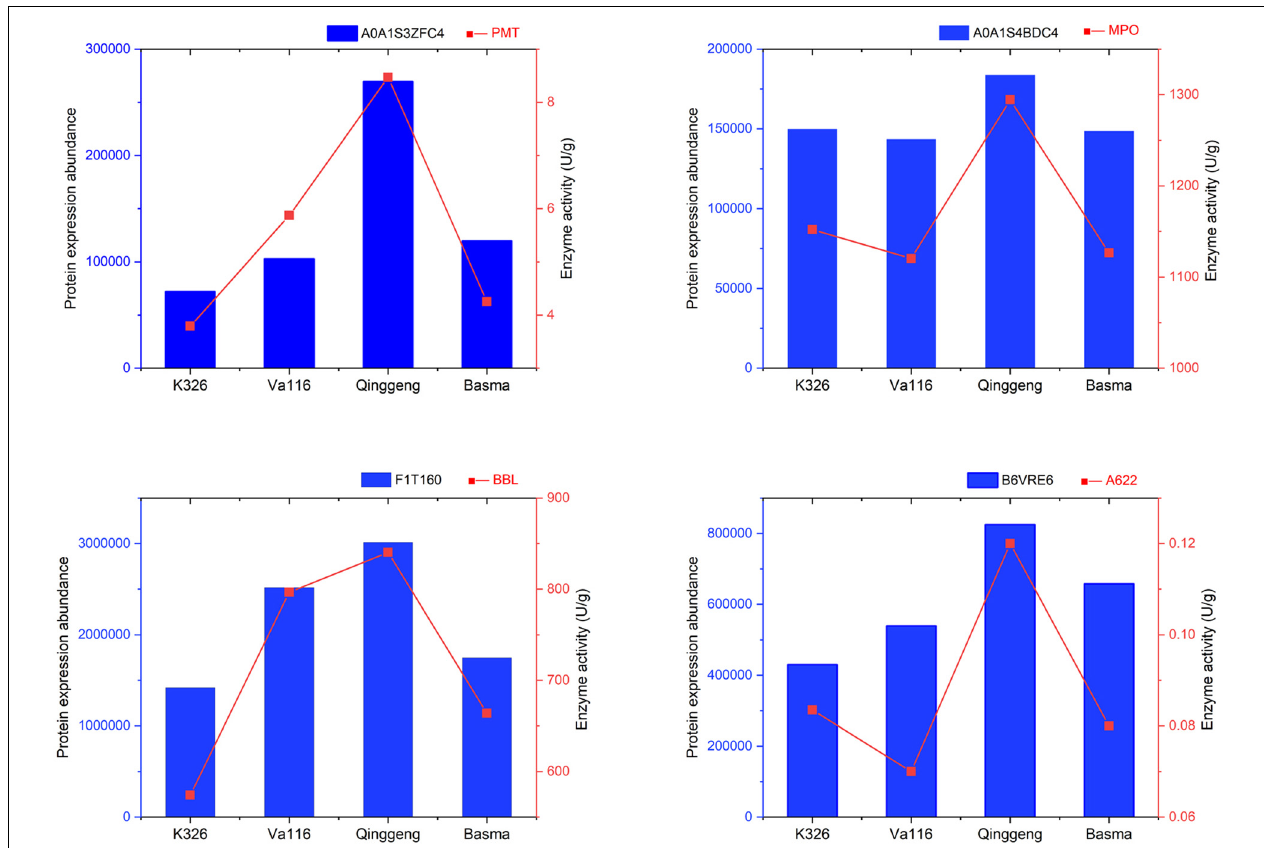
FIGURE 7 | Validation of proteomics data through enzyme activity determination. A0A1S3ZFC4, A0A1S4BDC4, F1T160, and B6VRE6 are the protein accessions numbers of genes putrescine N -methyltransferase (PMT), N -methylputrescine oxidase (MPO), berberine bridge enzyme-like (BBL), and isoflavone reductase-like protein (A622),